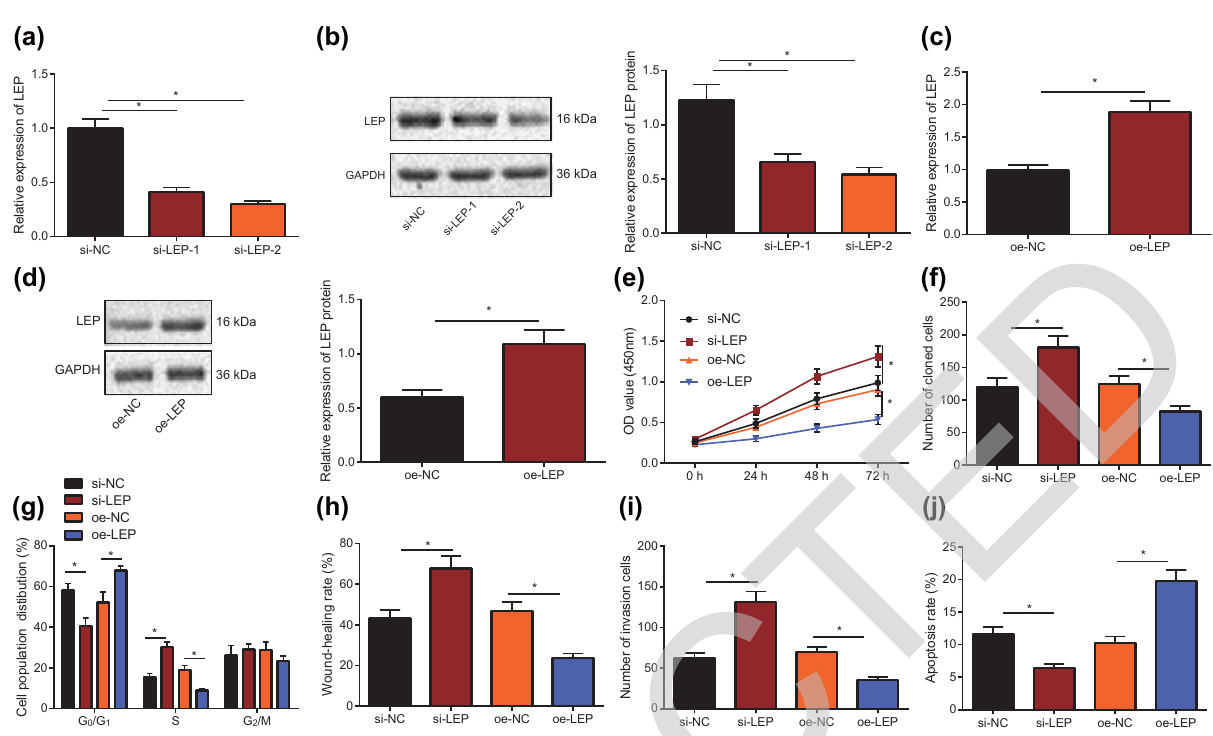
Figure 2: Downregulation of LEP expression promotes the progress of HTR - 8/SVneo cells. ( a ) RT - qPCR was used to screen the silencing e ffi ciency of LEP in HTR - 8/SVneo cells. ( b ) Western blot was used to screen the silencing e ffi ciency of LEP in HTR - 8/SVneo cells. ( c ) Overexpression of LEP in HTR - 8/SVneo cells was detected using RT - qPCR. ( d ) LEP overexpression in HTR - 8/SVneo cells was detected with Western blot. ( e ) CCK - 8 assay was carried out to determine the proliferation ability of HTR - 8/SVneo cells when LEP was overexpressed or silenced. ( f ) Clone formation assay was carried out to determine the cloning ability of HTR - 8/SVneo cells when LEP was overexpressed or silenced. ( g ) When LEP was overexpressed or silenced, the cell cycle distribution of HTR - 8/SVneo cells was tested through fl ow cytometry. ( h ) Scratch test was used to measure the migration ability of HTR - 8/SVneo cells when LEP was overexpressed or silenced. ( i ) The invasive capacity of the HTR - 8/SVneo cells was detected using Transwell test, when LEP was overexpressed or silenced. ( j ) HTR - 8/SVneo cells apoptosis was measured by fl owcytometry, when LEP was overexpressed or silenced; * indicates P < 0.05 ( the measurement data were shown as the mean ± standard deviation, and unpaired t - test was used for two sets of data statistics result comparison; single factor analysis of variance was used for multigroup data comparison; data at various time points were analyzed with two - factor analysis of variance, and the tests were repeated in triplicates )